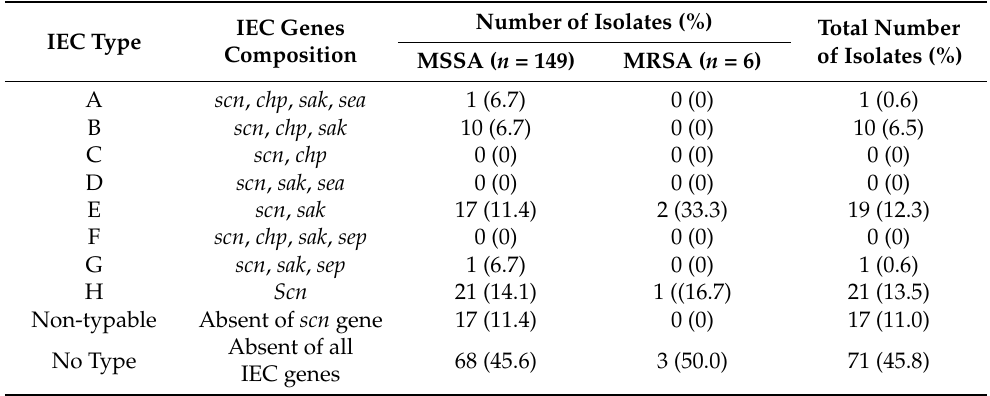
Table 4. Summary of IEC types of S. aureus isolates ( n =